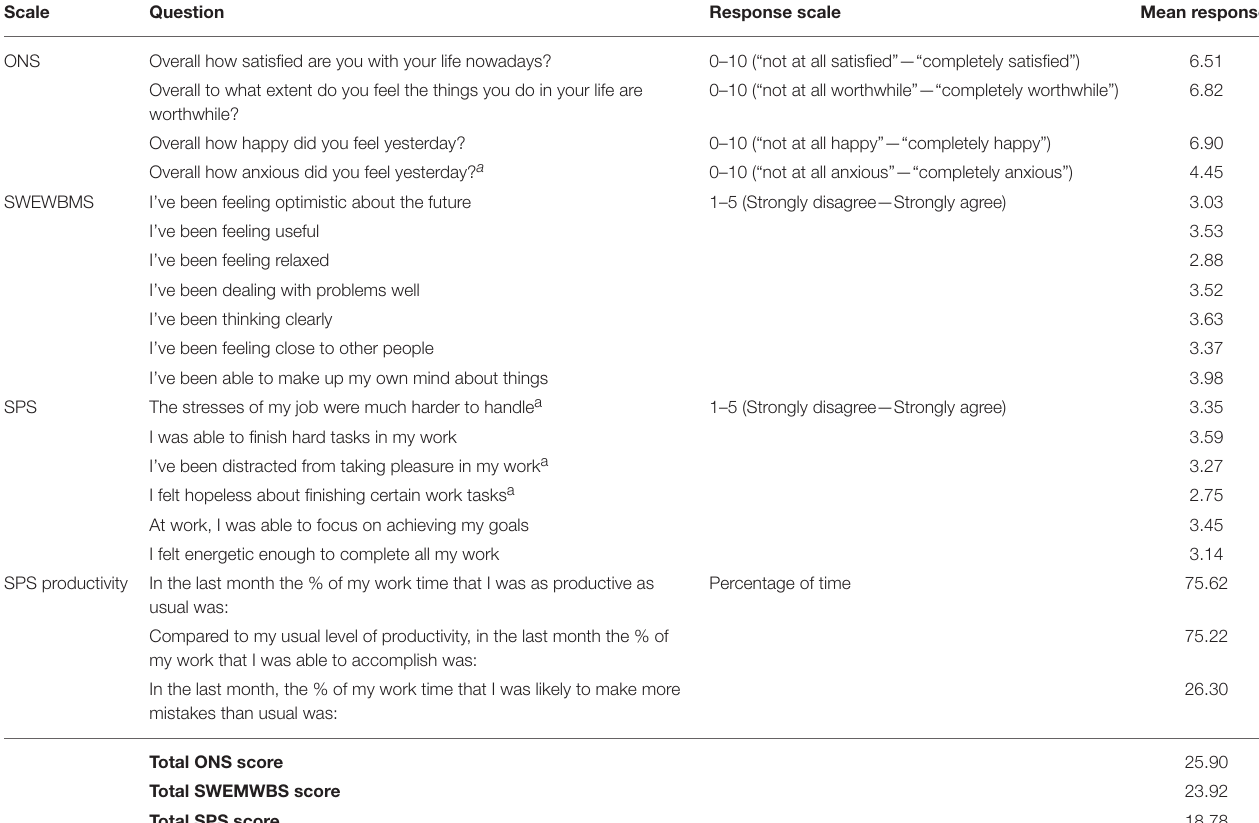
TABLE 5 | SWB Questions, response scales, and mean